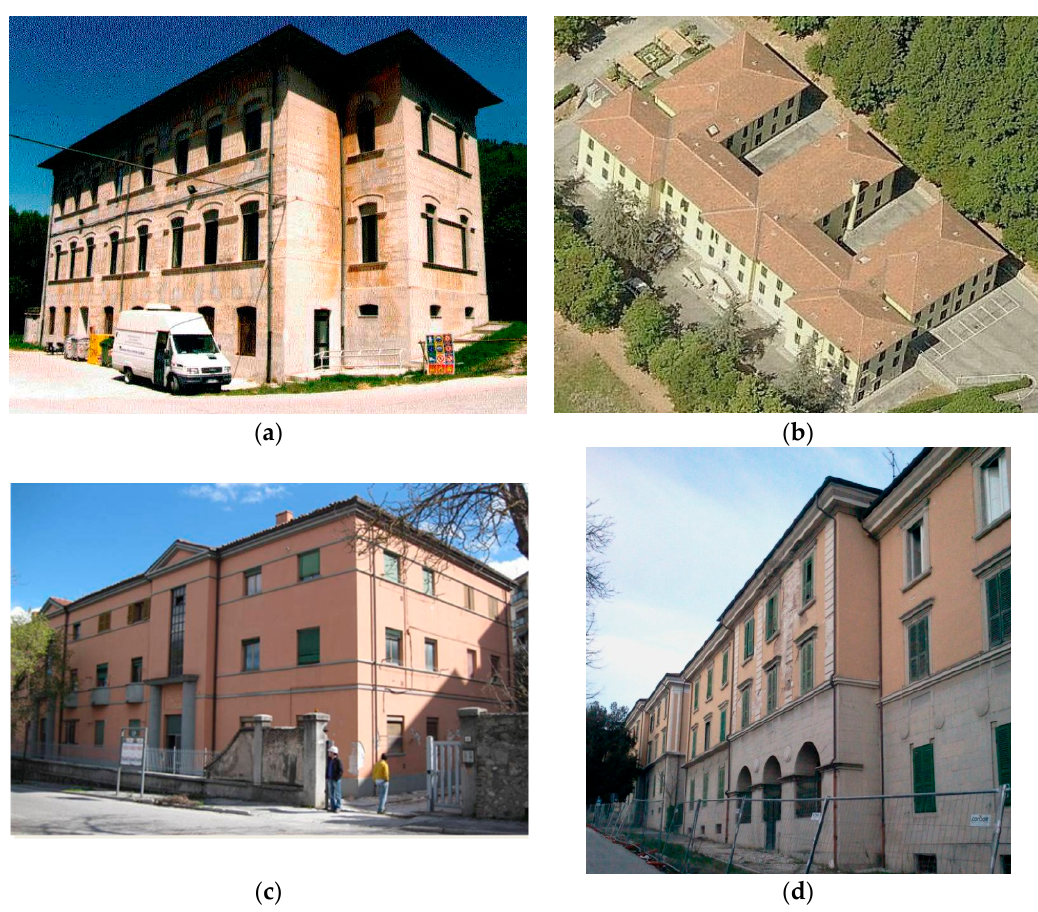
Figure 1. The four historic buildings where tests were carried out: ( a ) Building No. 1 (located in Belfiore, Foligno, Italy); ( b ) Building No. 2 (located in Lucca, Italy); ( c ) Building No. 3 (located in Porta Napoli, L’Aquila, Italy); ( d ) Building No. 4 (located in Via 20 Settembre, L’Aquila, Italy).